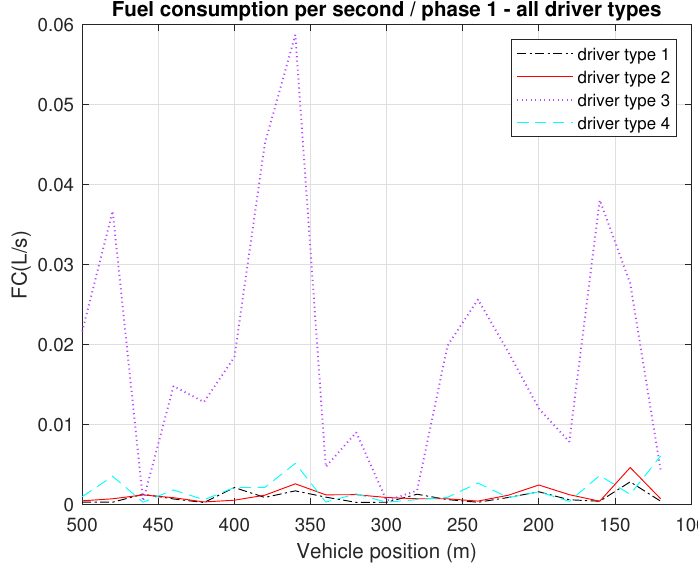
Figure 15. Instantaneous fuel consumption during phase 1 for all driver